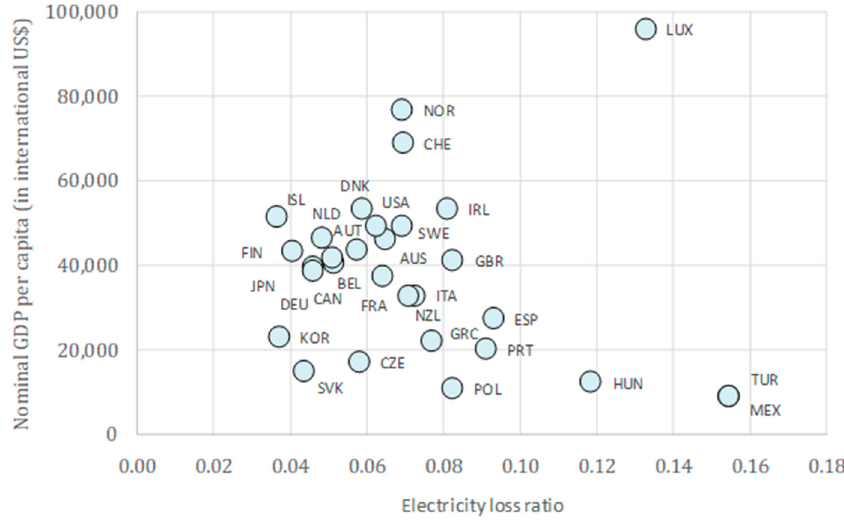
Figure A5. Electricity loss ratio and nominal GDP per capita.